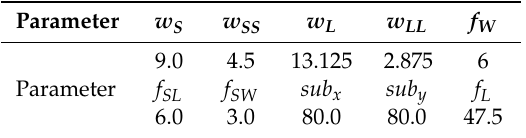
Figure 2. Comparison of rectangular slot with U-slot, when fed by the stripline, ( a ) voltage standing wave ratio (VSWR) of the rectangular slot and U-slot antenna, ( b ) broadside directivity of the rectangular slot and U-slot antenna, ( c ) radiation patterns of rectangular slot antenna and ( d ) radiation patterns of U-slot antenna ( e ) radiation patterns of the RCA with U-slot antenna at 15 GHz. Table 1. Parameter values for the stripline feed structure (in